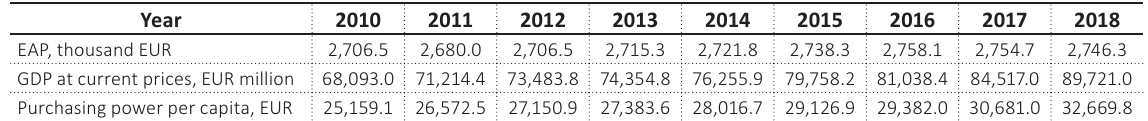
Table 1. Labor productivity